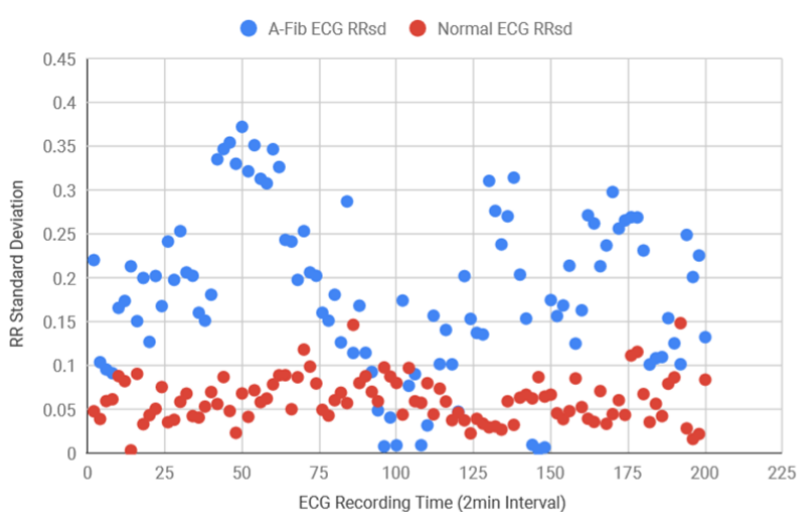
Figure 13. Variance in standard deviation for RR interval data collected from multiple subjects.